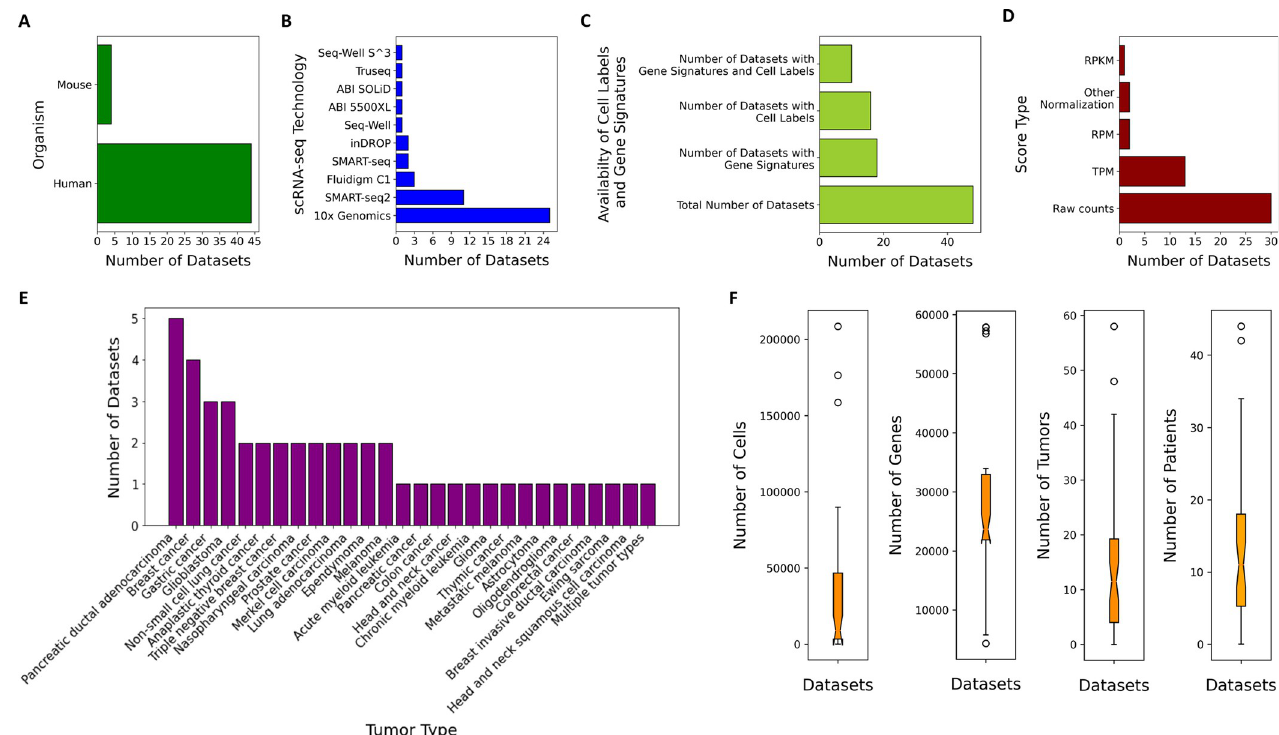
Fig 5. A summary of TMExplorer contents. Here, we provide a summary of the number of humans and mice datasets in TMExplorer (A); the number of datasets generated by various sequencing technologies (B); the number of datasets for which cell type labels and gene signatures are available (C); and the distributions of score types of different datasets (D) and the tumour types (E). In addition, boxplots of the number of cells, genes, tumours and patients across different datasets are provided (F).